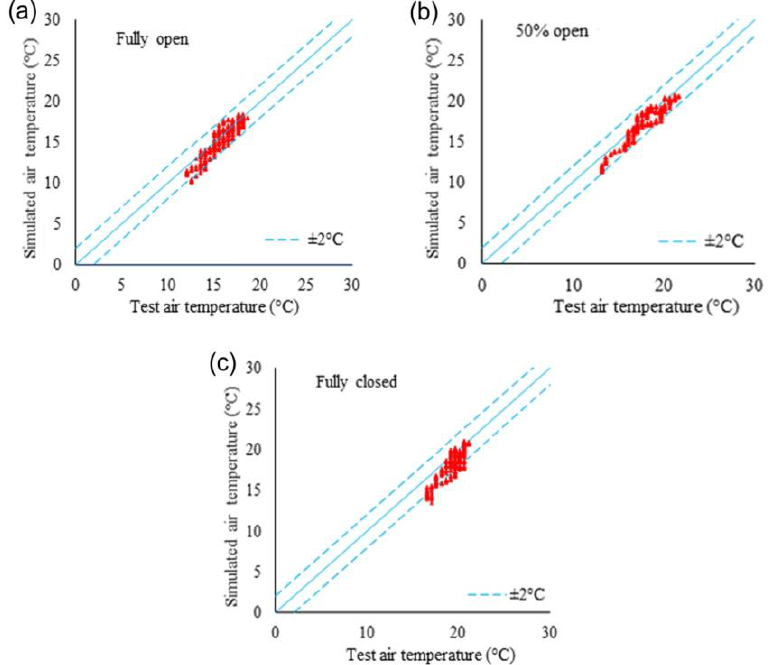
Figure 5. Comparison of indoor air temperatures of the master bedroom between numerical simulated methods and measured data under three window conditions: ( a ) fully open; ( b ) half open; ( c ) fully closed.